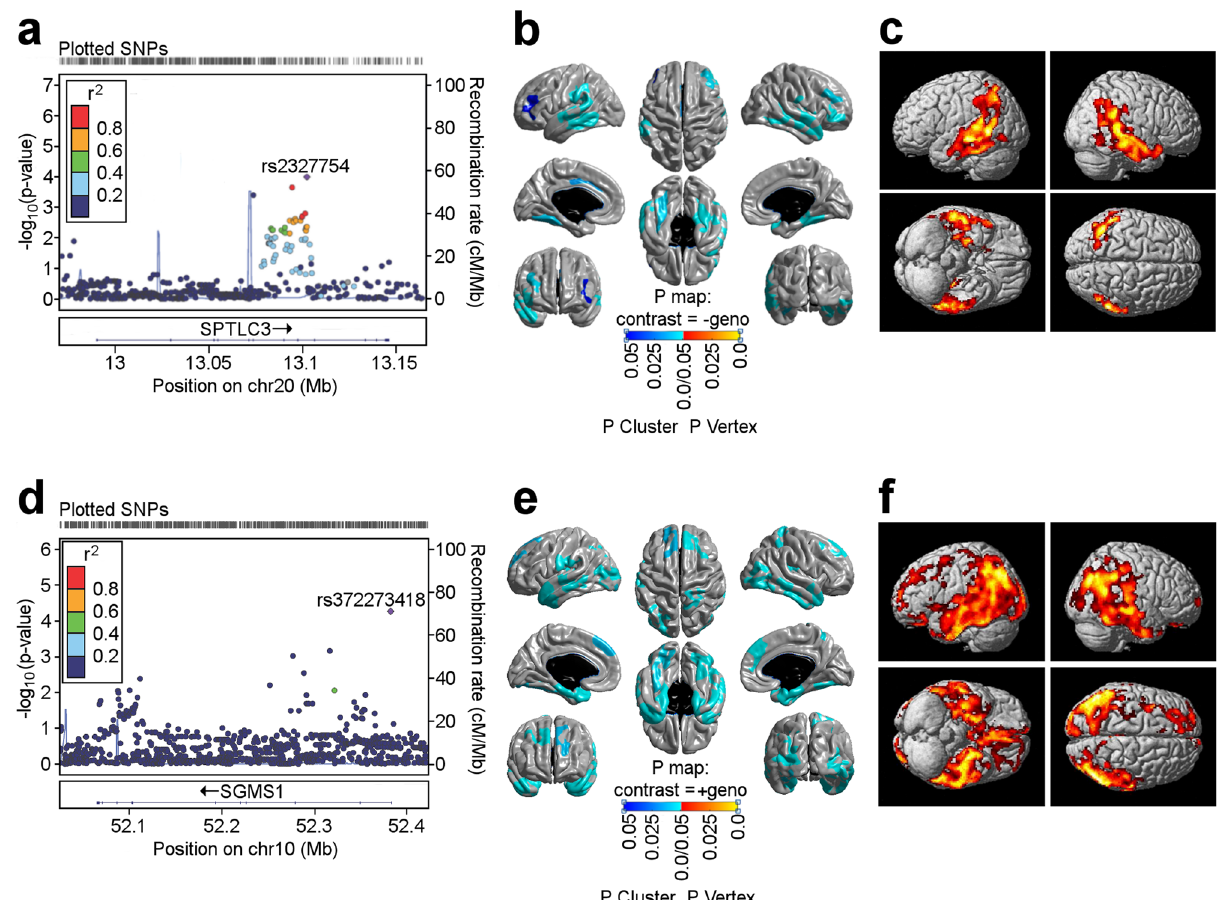
Fig. 3 Association of genetic variants in SPTLC3 and SGMS1 with structural (MRI) and molecular (FDG-PET) neuroimaging phenotypes. a Gene-based association analysis of SPTLC3 with cognitive performance (Rey auditory verbal learning test total score). d Gene-based association analysis of SGMS1 with global brain glucose metabolism. b and e Surface-based whole brain analysis of cortical thickness (brain atrophy measured from MRI scans) for SPTLC3 and SGMS1 . c and f Voxel-based whole brain analysis of brain glucose metabolism measured from FDG-PET scans for SPTLC3 and SGMS1 . Red color suggests a decrease in glucose metabolism. chr chromosome, FDG fl uorodeoxyglucose, MRI magnetic resonance imaging, PET positron emission tomography, SNP single nucleotide